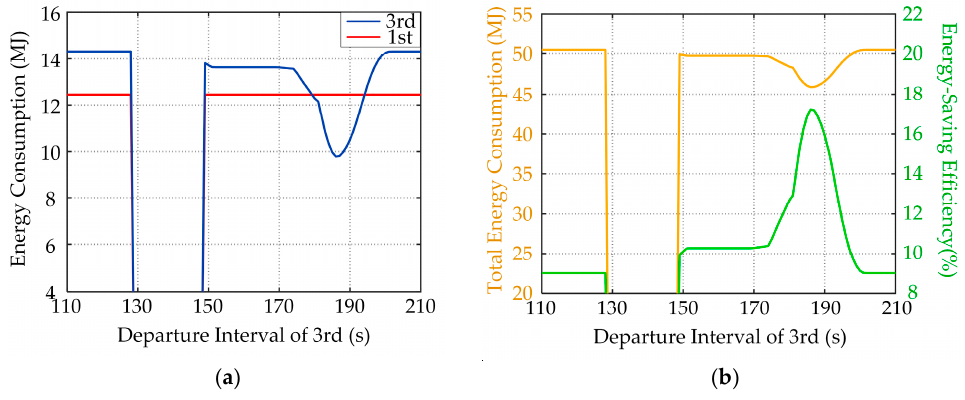
Figure 16. Results under four-mode operation: ( a ) energy consumption of the 1st train and the 3rd train; and ( b ) total energy consumption and energy-saving efficiency.